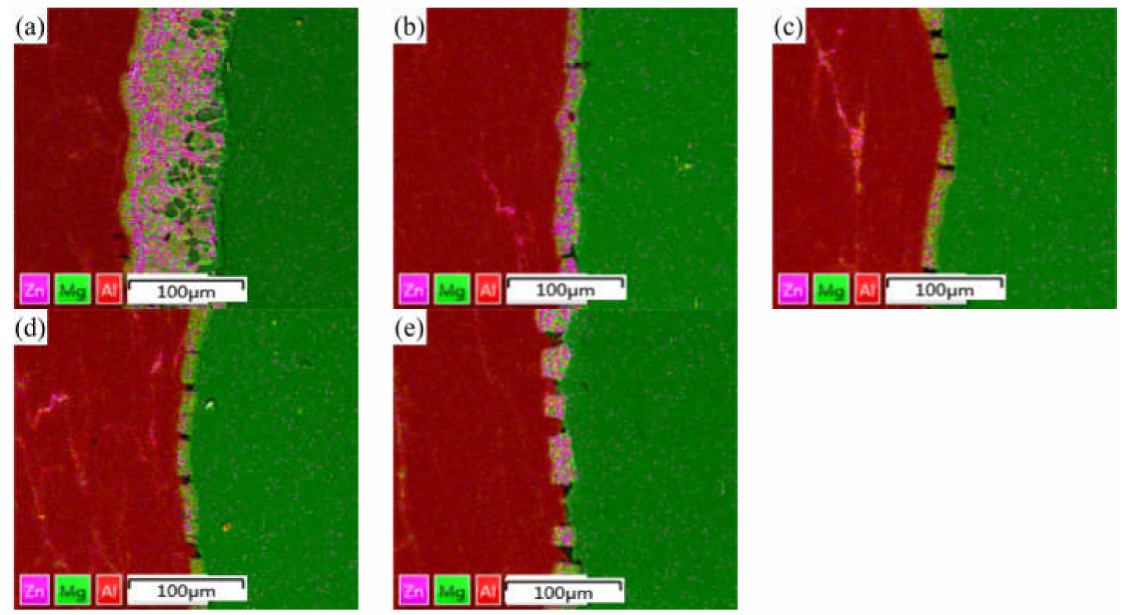
Figure 6. EDS surface scanning results of Al/Mg composite plate interface under different rolling passes: ( a ) not rolled, ( b ) first pass, ( c ) second pass, ( d ) third pass, and ( e ) fourth